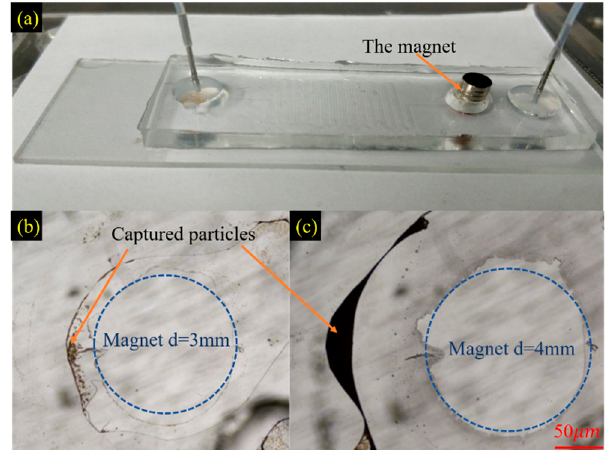
Figure 6. ( a ) Microfluidic chip of a simple S-shaped micromixer with embedded baffle to verify the magnetic capture capability and the capturing performance of magnets with diameters of ( b ) 3 mm and ( c ) 4 mm within the chamber.